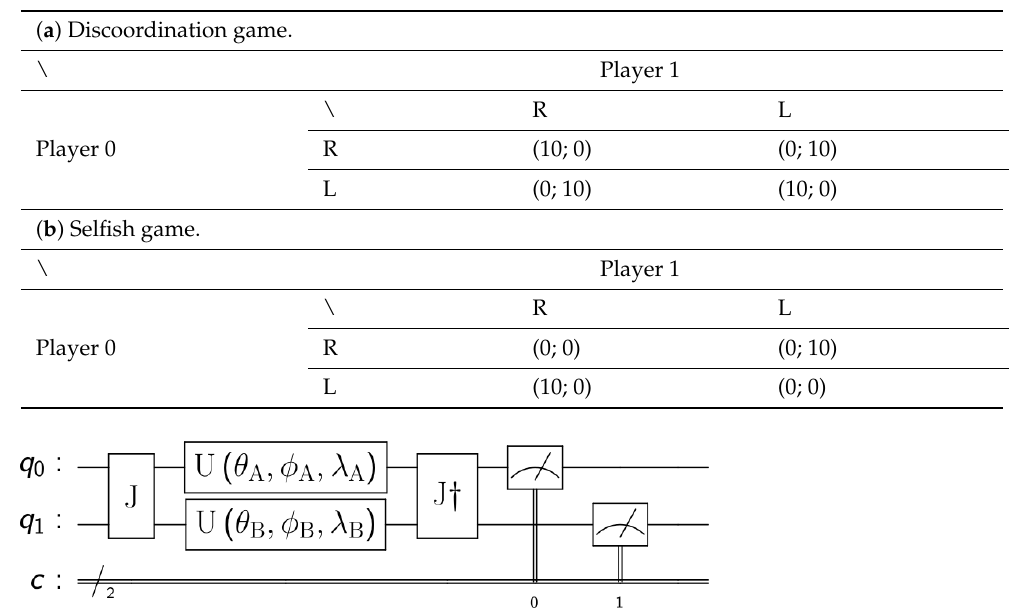
Table 4. Payoff matrix representation of other useful games.